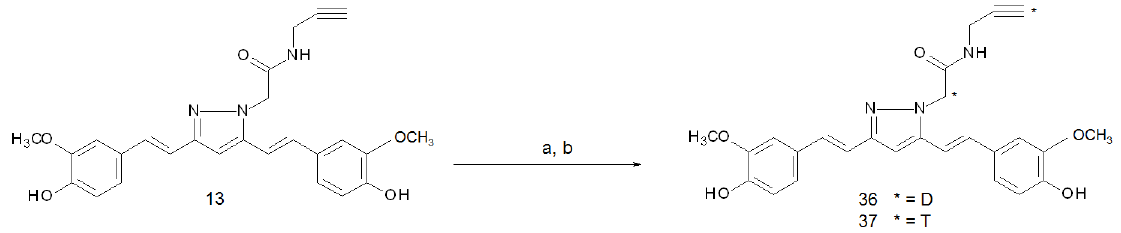
Figure 12. Reagents and conditions: ( a ) n-BuLi, iPr 2 NH, THF dry, 0° C to RT ( b ) [ 2 H]H 2 O or [ 3 H]H 2 O, 0.5 h.